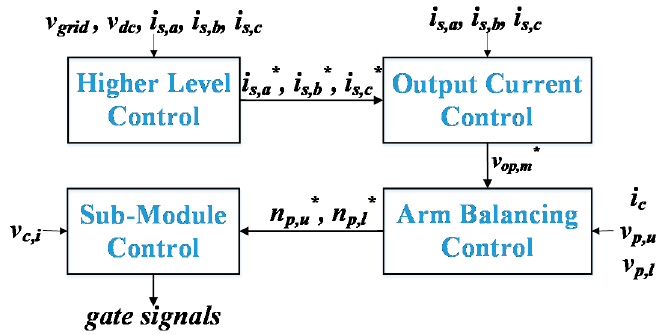
Figure 2. MMC control block diagram.